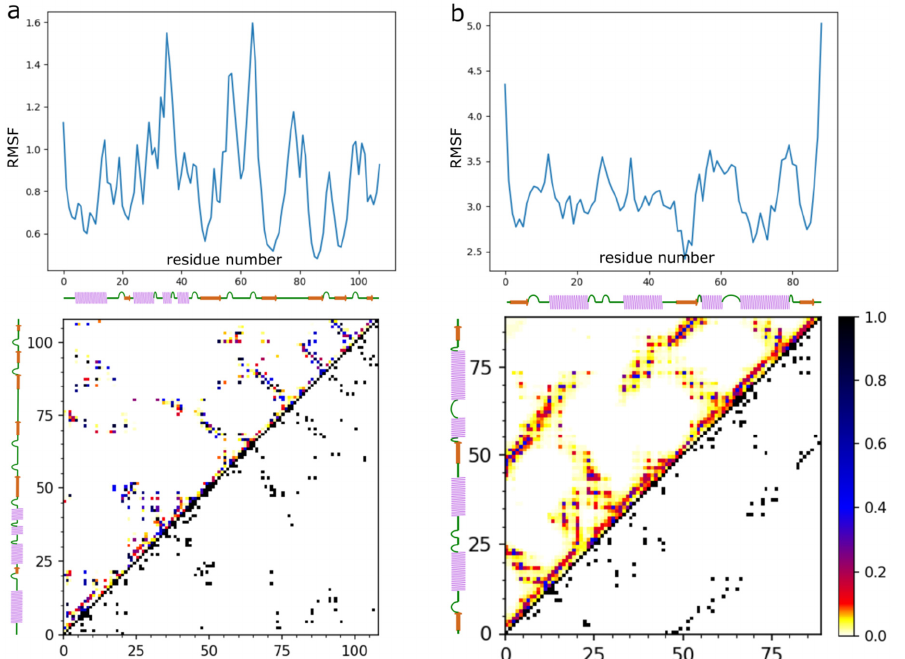
Figure 4. Characterization of barnase/barstar flexibility in the docking simulation. The figure shows RMSF plots (upper panels) and contact maps (lower panels) for ( a ) the barnase receptor and ( b ) the barstar ligand. The RMSF profile (see Methods) and contact maps showing the frequency of contacts are derived from the entire simulation (derived from 10,000 models).